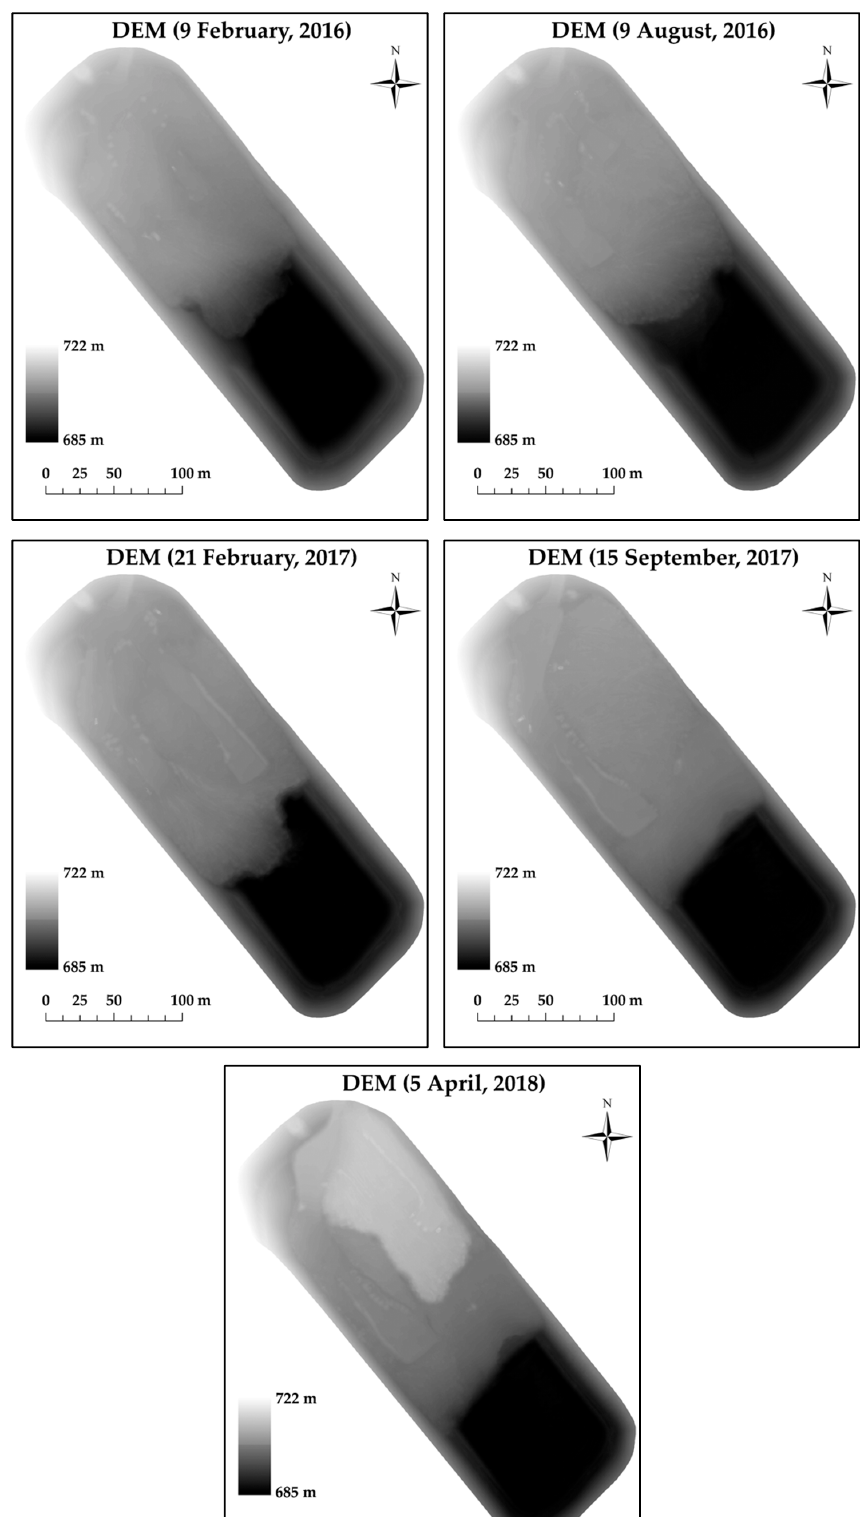
Figure 5. ( a ) Clipped tiled model which includes only the storage area; ( b ) clipped DEM corresponding to the clipped tiled model.